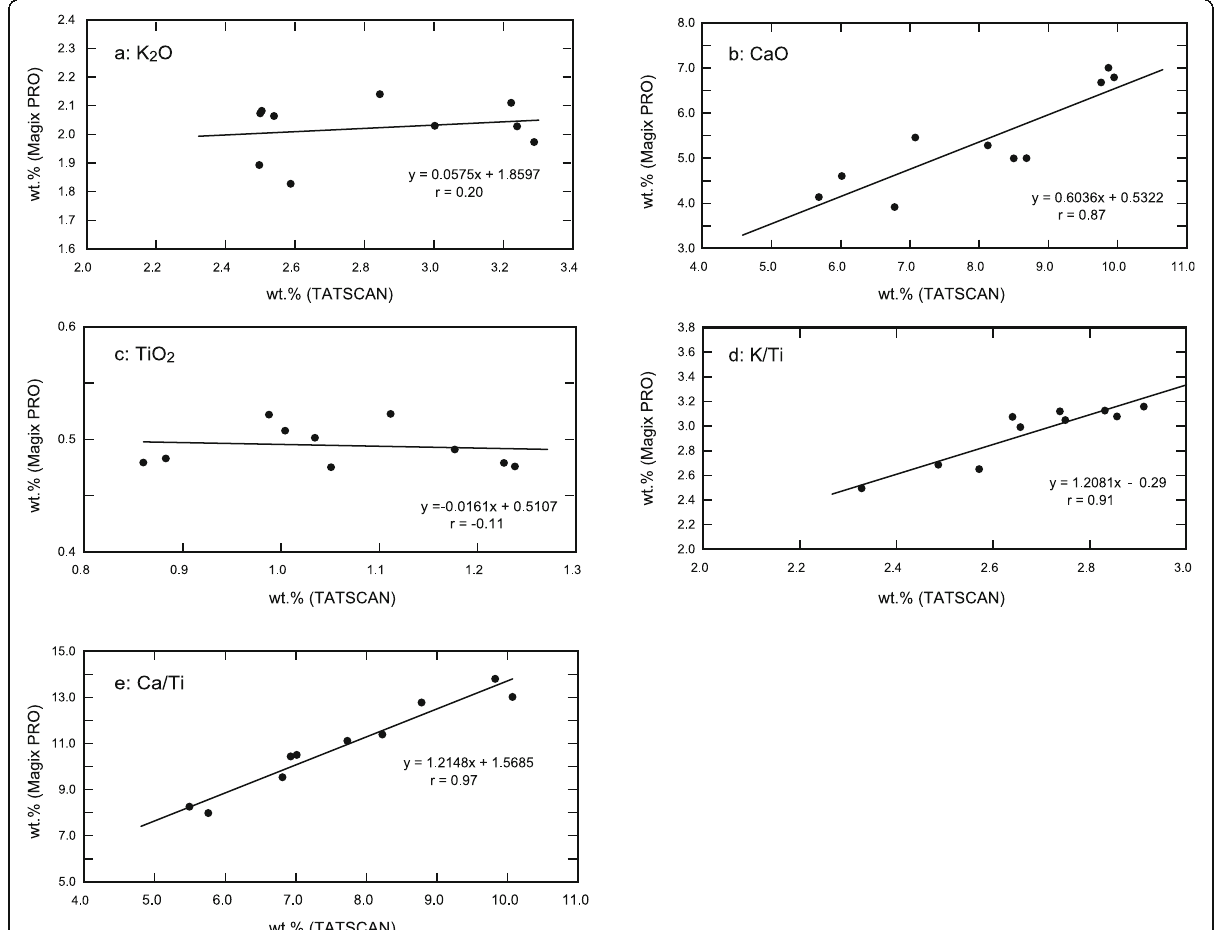
Fig. 5 The relationships between the major element abundances between TATSCAN-F2 and Magix PRO analyses for important proxies discussed in this